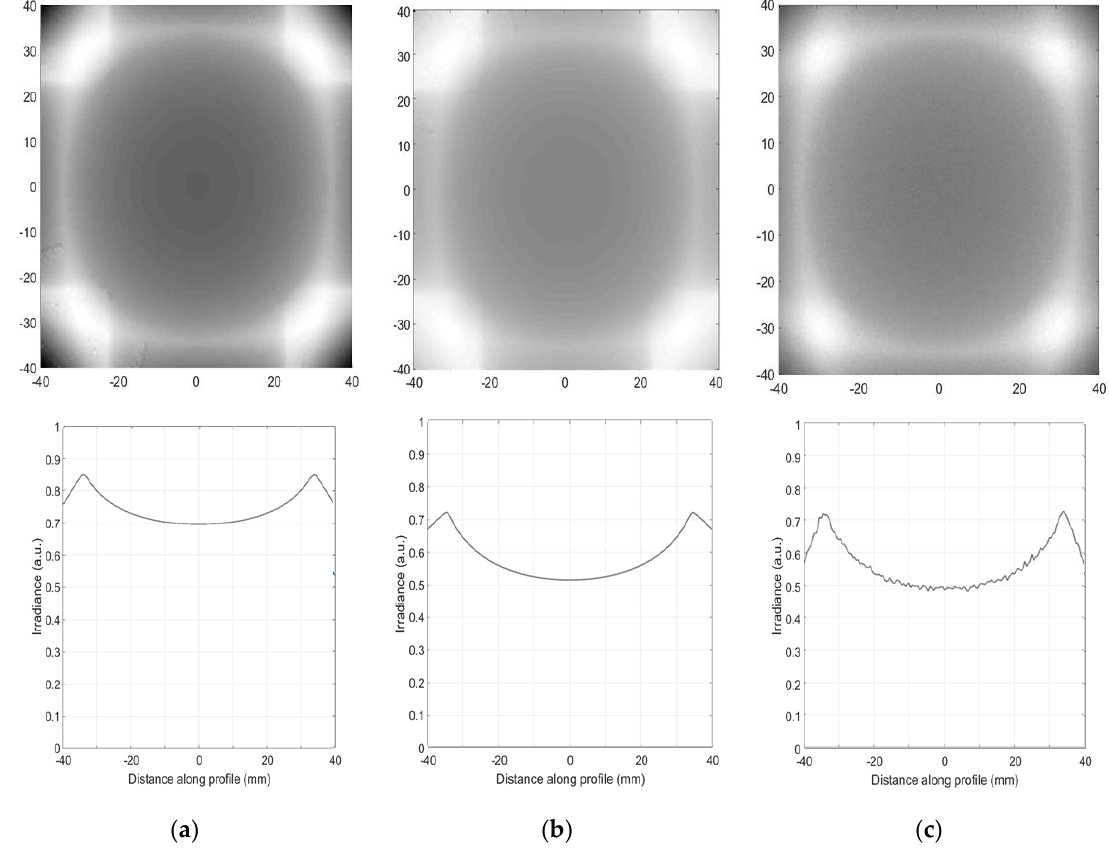
Figure 12. Irradiance pattern and central irradiance profile at the detector for refractive optical system of section 3: ( a ) computed by standard flowline vector potential method; ( b ) computed by optical path length (OPL) correction in flowline vector potential method; ( c ) computed by raytrace.